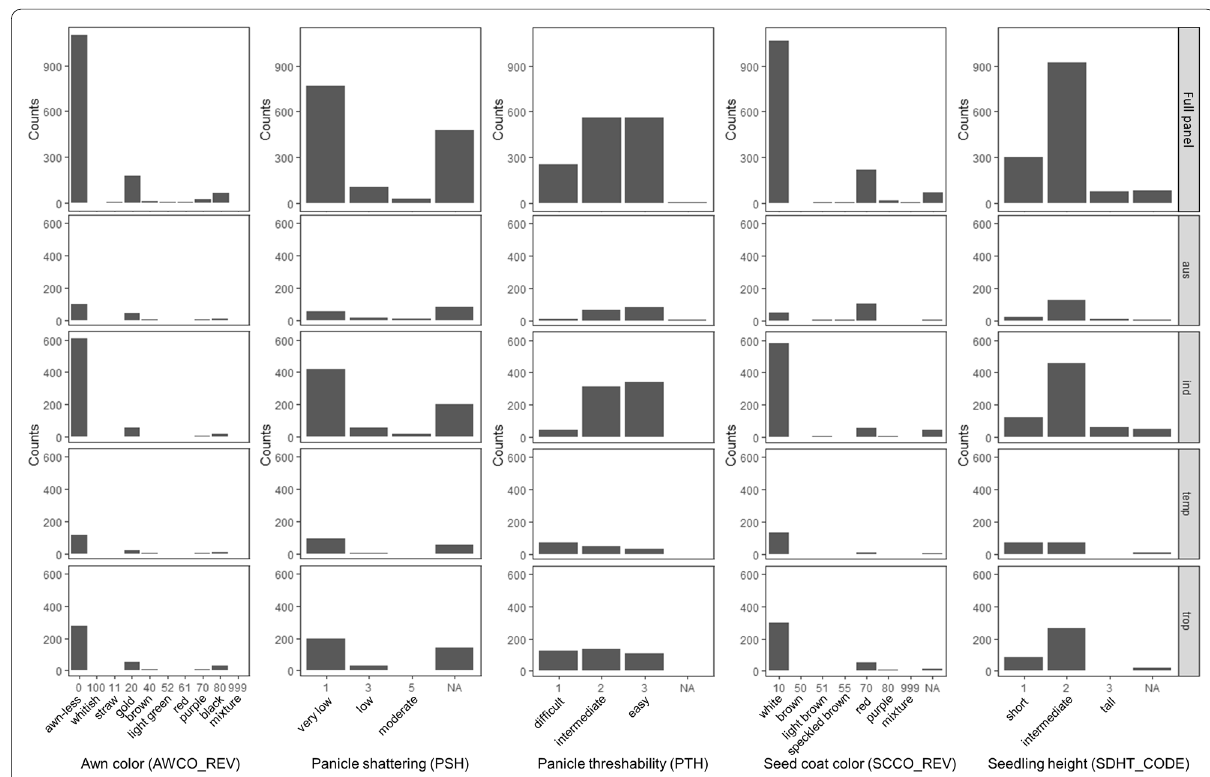
Fig. 5 Phenotypic distribution of the five target traits in 1378 rice accessions in the full panel and within each sub‑population. For awn color (AWCO_REV), 0, 11, 20, 40, 52, 61, 70, 80, 100, and 999 stand for awn‑less, awn with color whitish, straw, gold, brown, light green, red, purple, black, and mixture, respectively. For panicle shattering (PSH), 1 indicates very low shattering (< 1%), 3 indicates low shattering (3%), 5 indicates moderate shattering (15%). For panicle threshability (PTH), 1 indicates difficult for threshing, 2 indicates intermediate for threshing (25% to 50% grains removed), 3 indicates easy for threshing (> 50% grains removed). For seed coat color (SCCO_REV), 10, 50, 51, 55, 70, 80, and 999 stand for white, brown, light brown, speckled brown, red, purple, and mixture, respectively. For seedling height (SDHT_CODE), 1 indicates short seedling (< 30 cm), 2 indicates intermediate seedling (30‑59 cm), 3 indicates tall seedling (> 59